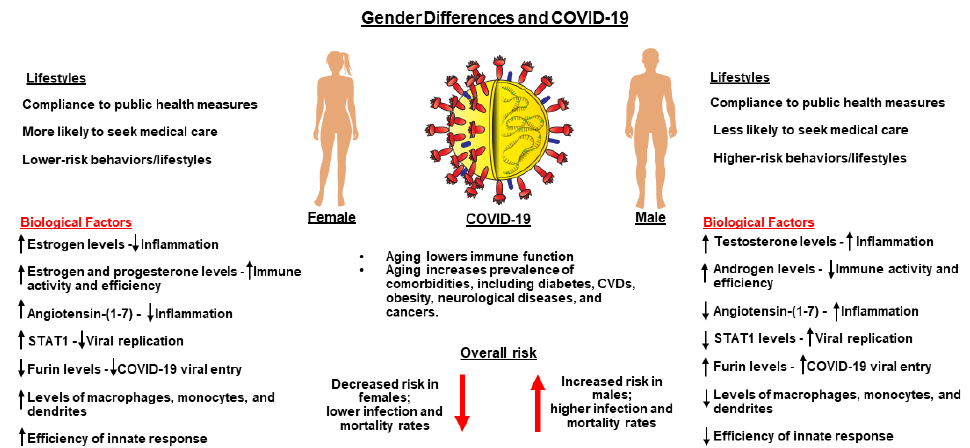
Figure 4. Sex and gender differences and their connection to COVID-19. Several biological factors demonstrate a predisposition of males for higher levels of testosterone and androgen, less efficient innate immune responses, and less ability to repair damages, thus allowing for higher severe infection and mortality rates than their female counterparts. Females demonstrate certain factors such as the presence of estrogens and progesterone, more effective innate immune responses, and other conditions that limit COVID-19 ′ s entry and subsequent infection. Independent of gender, age plays an important role in disease severity. Hormonal balances, lowered immune function, and increased comorbidity prevalence associated with age present opportunities for higher mortality rates and increased disease severity.